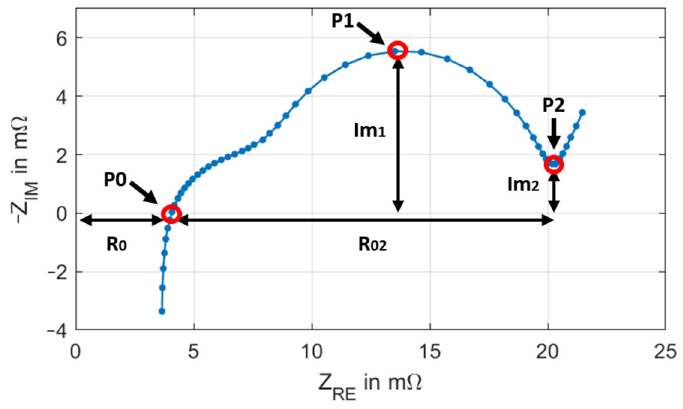
Figure 7. Schematic representation of an impedance spectrum with characteristic points that were used for evaluation.